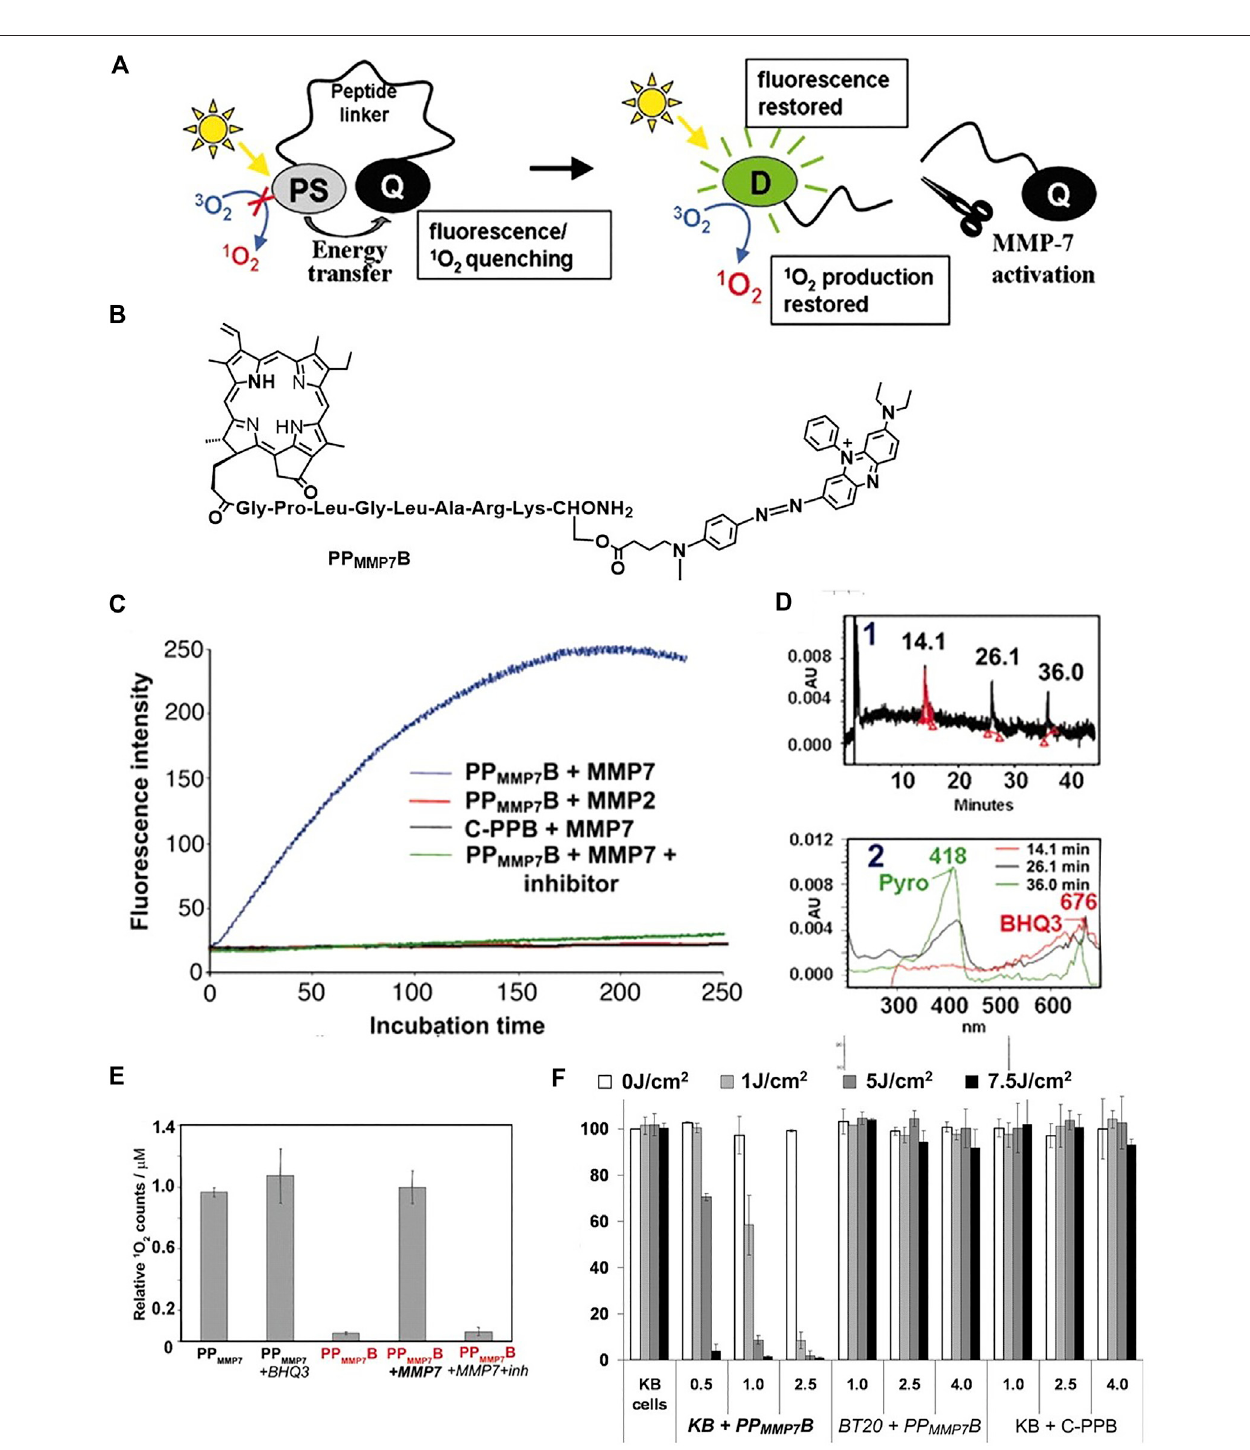
FIGURE 5 | (A) The concept of photodynamic molecular beacons. (B) Molecular structure of PP MMP7 B. (C) Fluorescence kinetics of different groups. (D) HPLC spectrum of PP MMP7 B + MMP7 incubated at 37 ° C for 2 h and corresponding UV-vis spectra. (E) The relative 1 O 2 counts of different groups. (F) Photodynamic cytotoxicity determinedby MTT assay asafunction ofPSand lightdoses, compared with untreated cells. Copyright (2007) National Academy ofSciences (Zheng et al.,